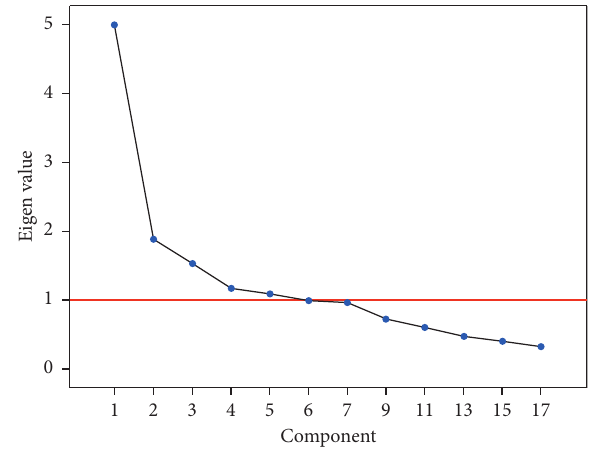
Figure 1: Screen plot of the PCA. Table 4: Total variance explained for